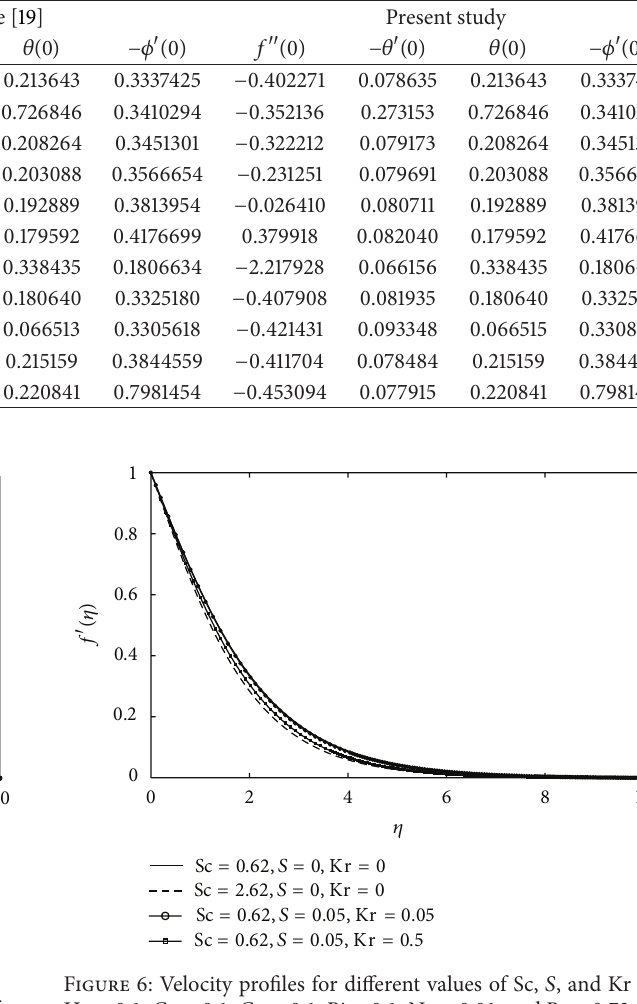
Figure 5: Velocity profiles for different values of Gr, 𝑆 , and Kr for Ha = 0.1 , Gc = 0.1 , Sc = 0.62 , Bi = 0.1 , Nc = 0.01 , and Pr = 0.72 .